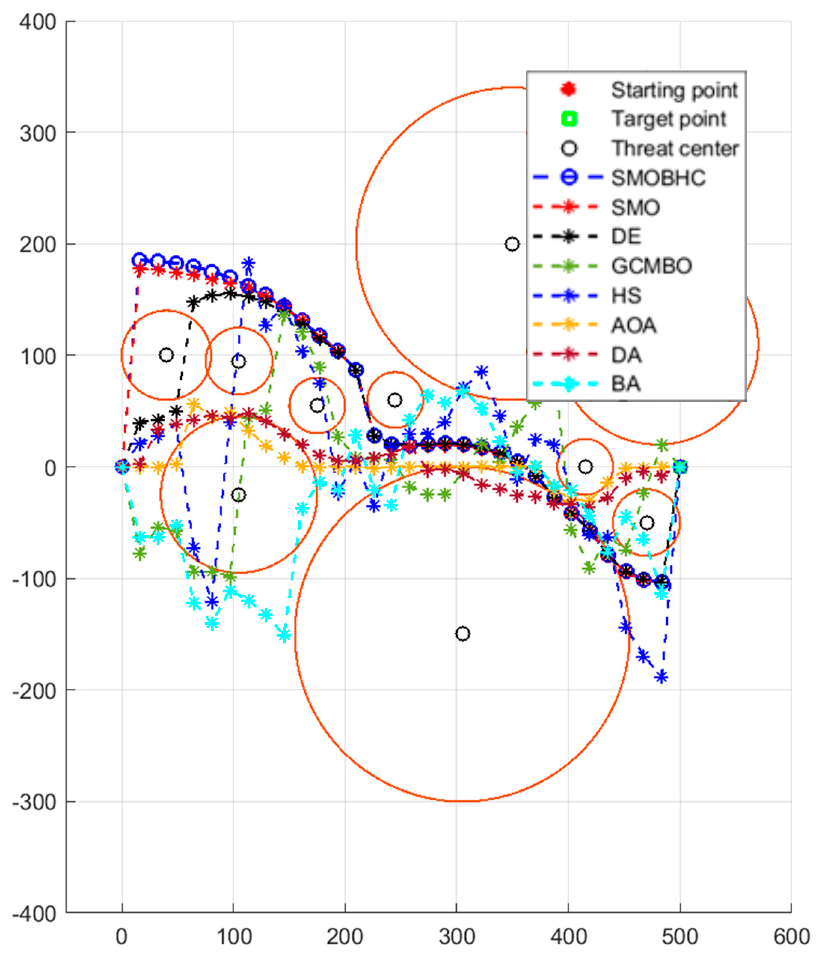
Figure 12. Comparison between SMOBHC and other seven algorithms for battlefield 1 with 𝐷 = 30 .